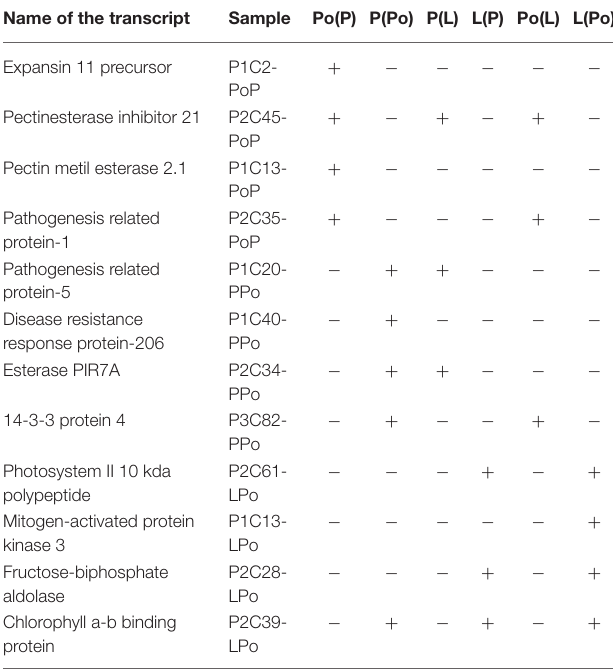
TABLE 2 | Selected gene products for pPCR validation. Name of the